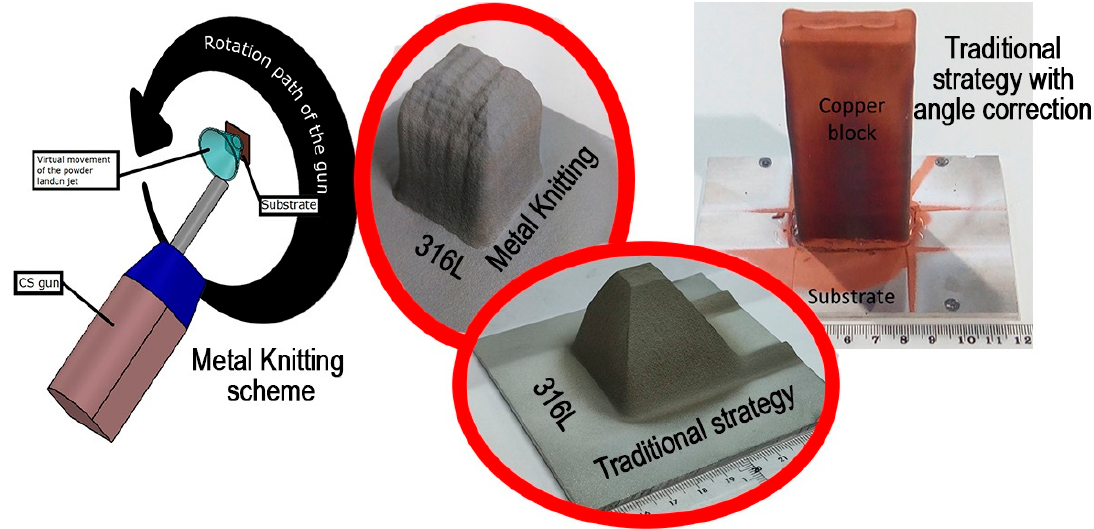
Figure 7. Metal Knitting, a CSAM alternative strategy to the traditional deposition. Reprinted with permission from Ref. [171], Springer Nature, 2020. Unit: mm.